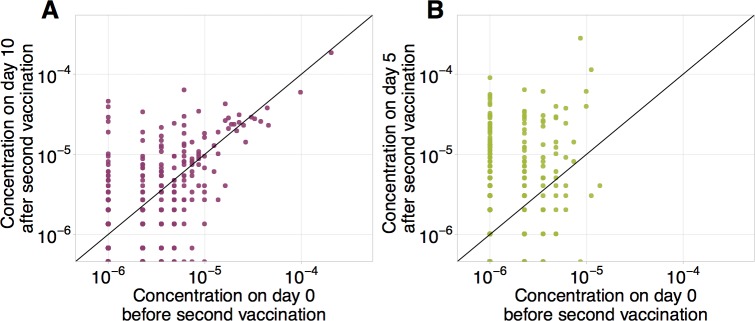
Frequencies of CD8+ and CD4+ YF-responding clonotypes before and after secondary immunization.Frequencies of CD8+ (A) and CD4+ (B) clonotypes having responded to the primary YFV17D immunization in bulk before (x-axis) versus at the peak of the response to booster immunization (y-axis). Diagonal line shows identity.